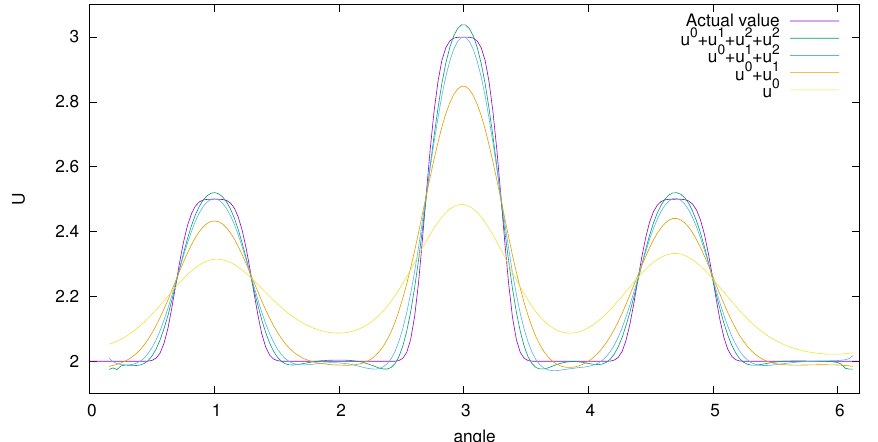
Figure 2. Recovered unknown interior boundary for the example 1 with no-noise.